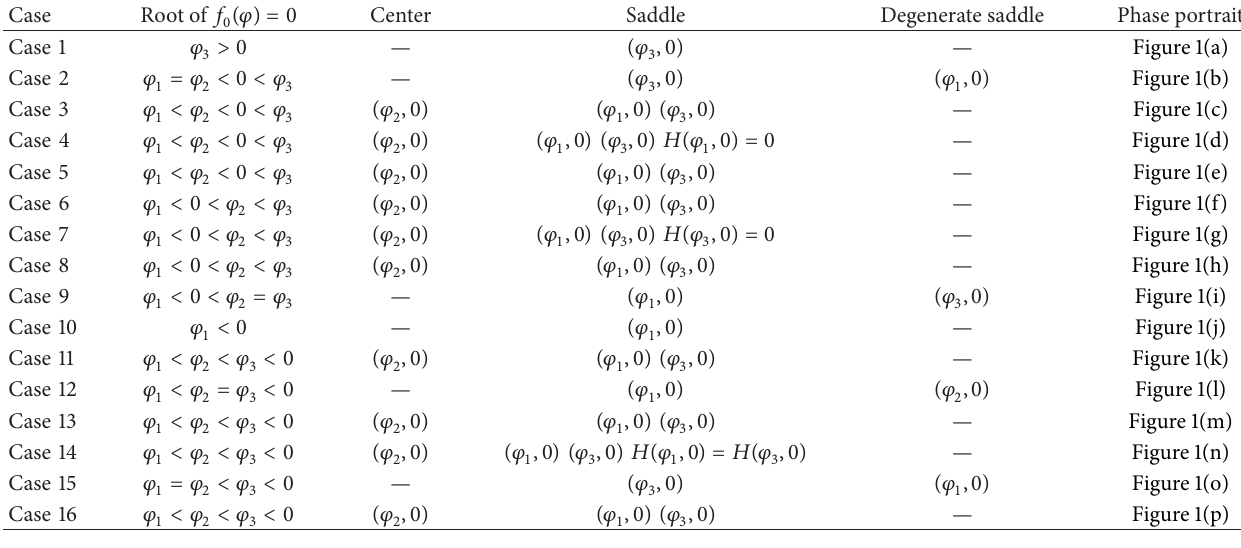
Table 1: The singular point and phase portrait for different